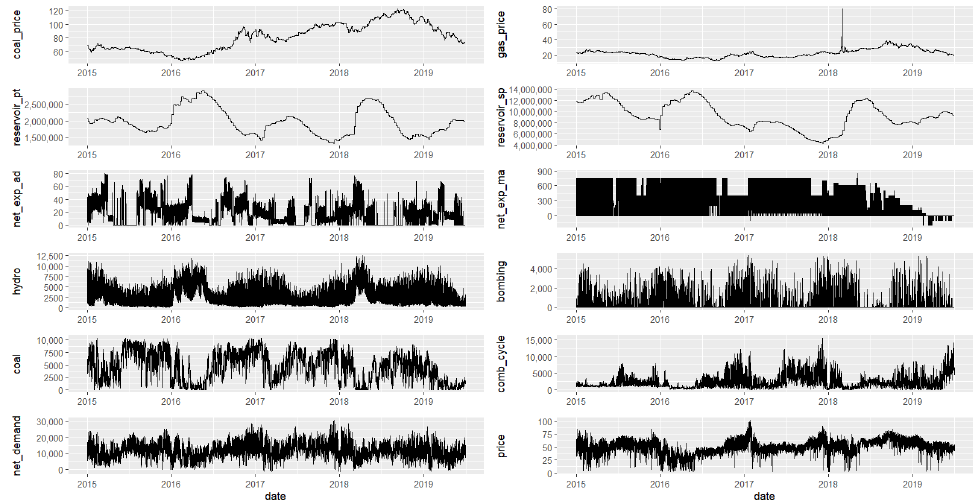
Figure 2. Time series for all possible variables to be used in this study between 1 January 2015 and 30 June